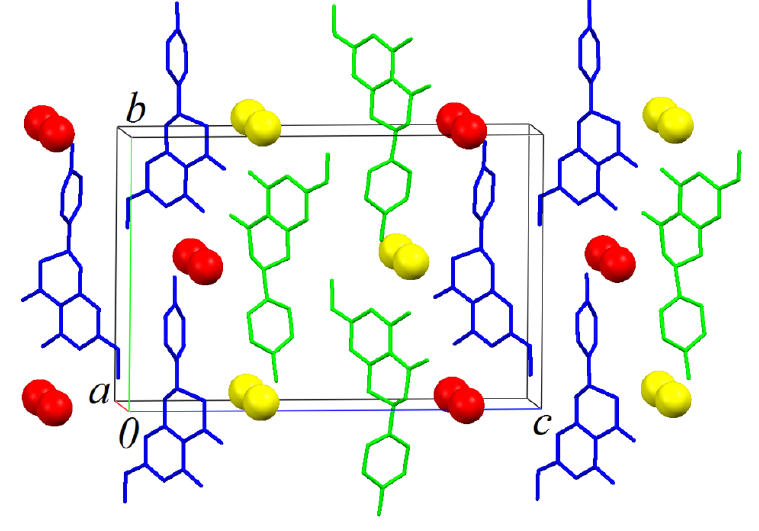
Figure 7. The crystal packing illustration of sakuranetin-monohydrate onto the bc